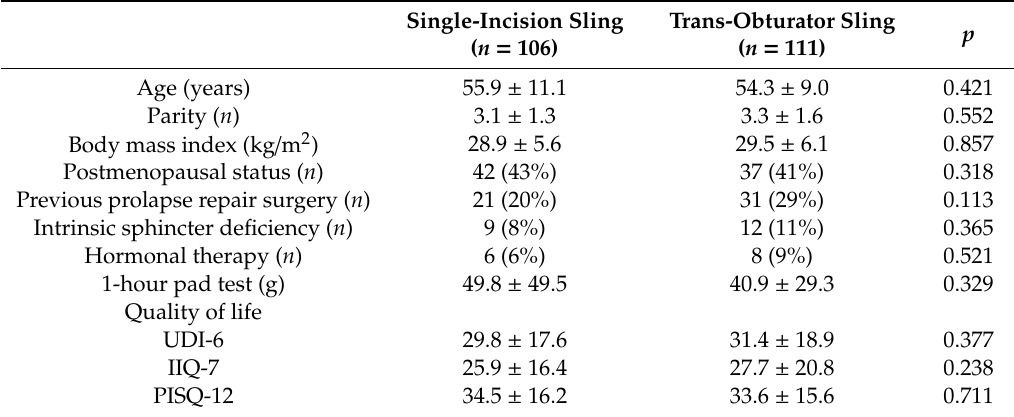
Table 1. Baseline characteristics of the women who received a single-incision or trans-obturator